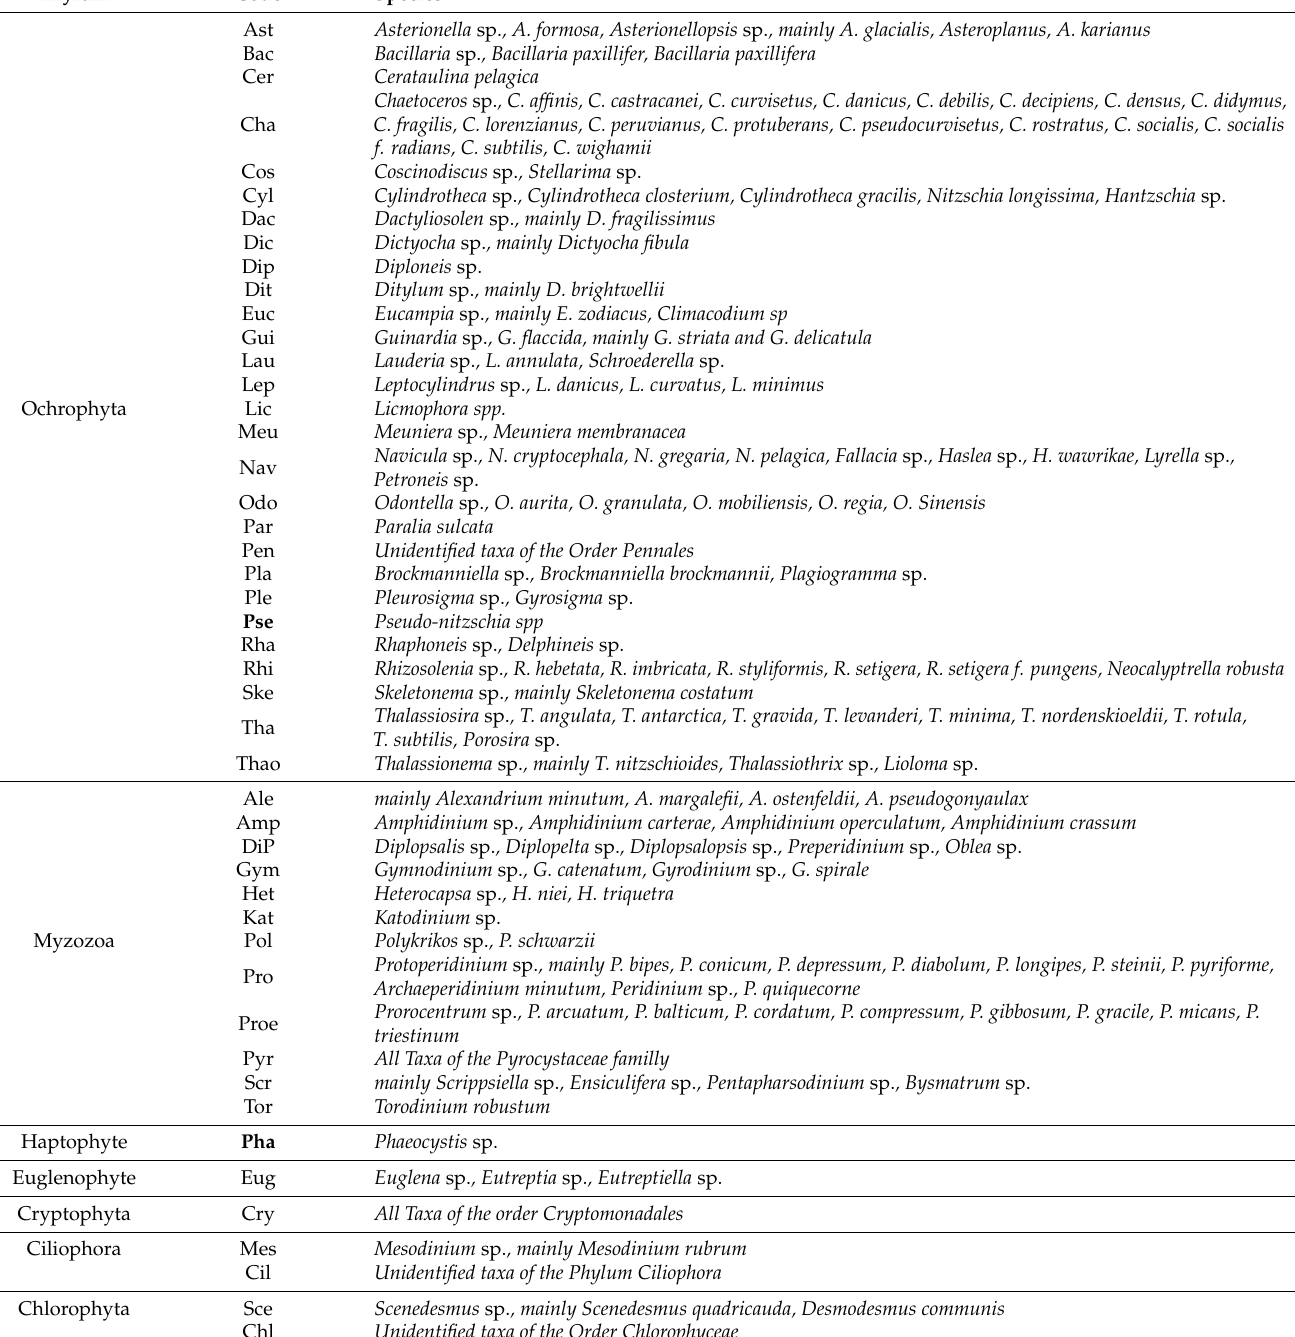
Table 1. List of the 47 phytoplanktonic taxonomic units used in the study. The code in bold are the harmful taxum